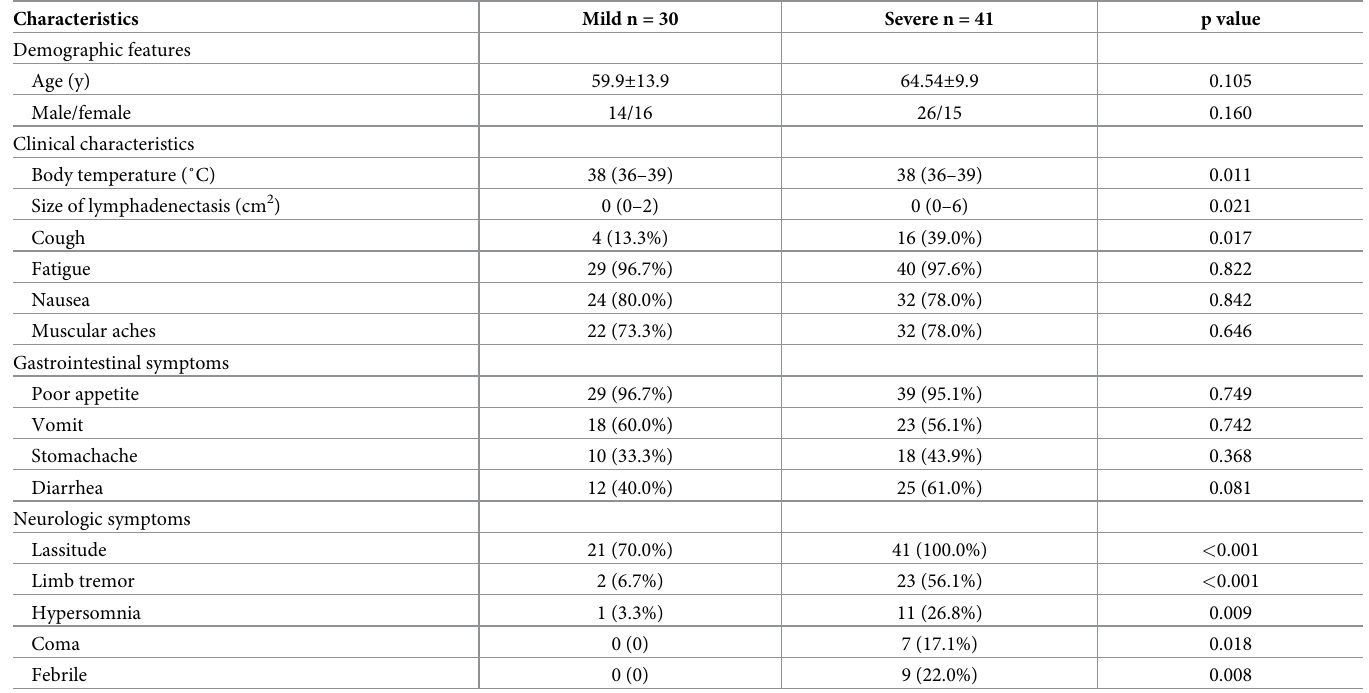
Table 1. Demographic and clinical characteristics of SFTS patients.